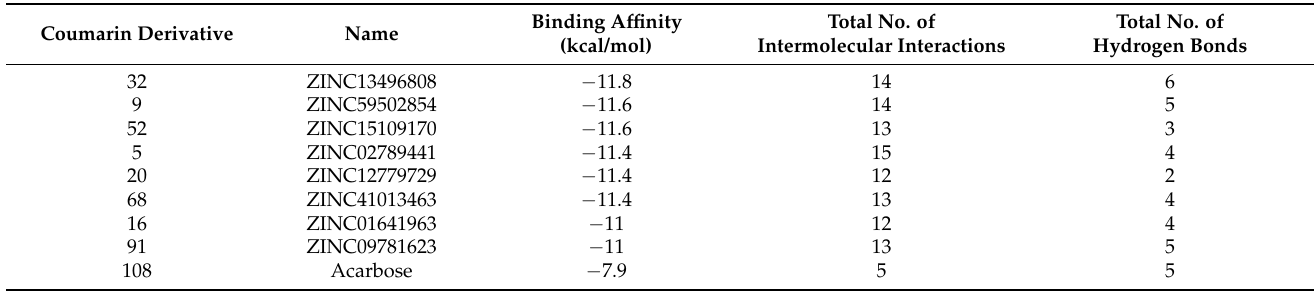
Table 5. Virtual screening of selected coumarin derivatives from pharmacophore studies for α -glucosidase.